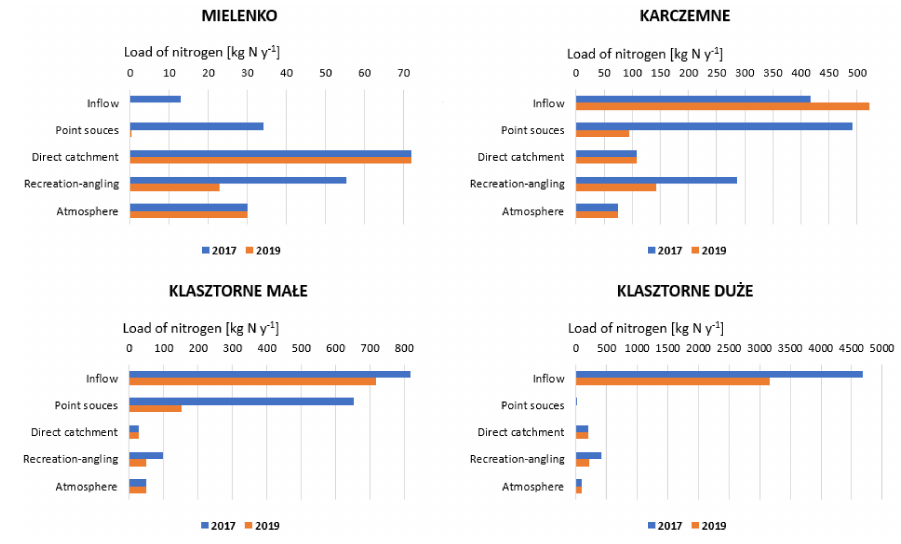
Figure 4. Annual load of nitrogen (N) (kg N y -1 ) entering to Kartuzy lake